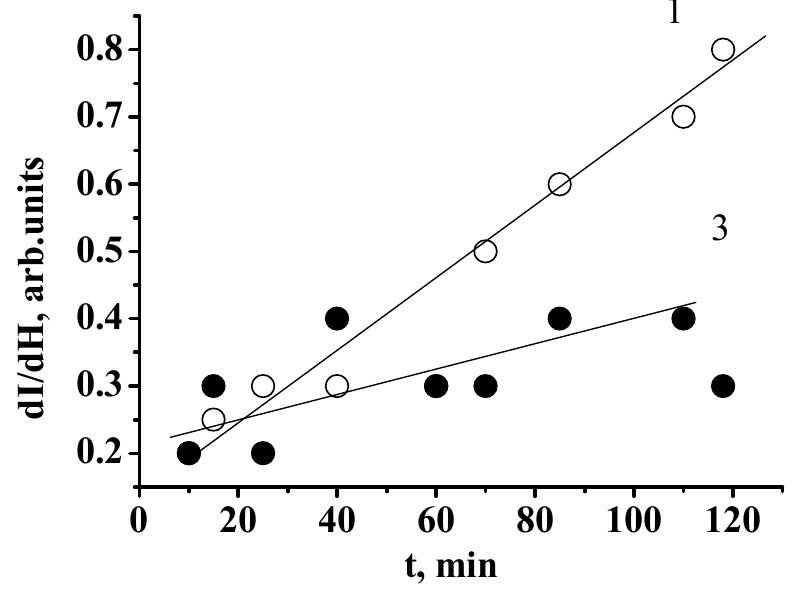
Figure 2. Electron paramagnetic resonance (EPR) spectra of ferriin in frozen BZ solution at 100 K.